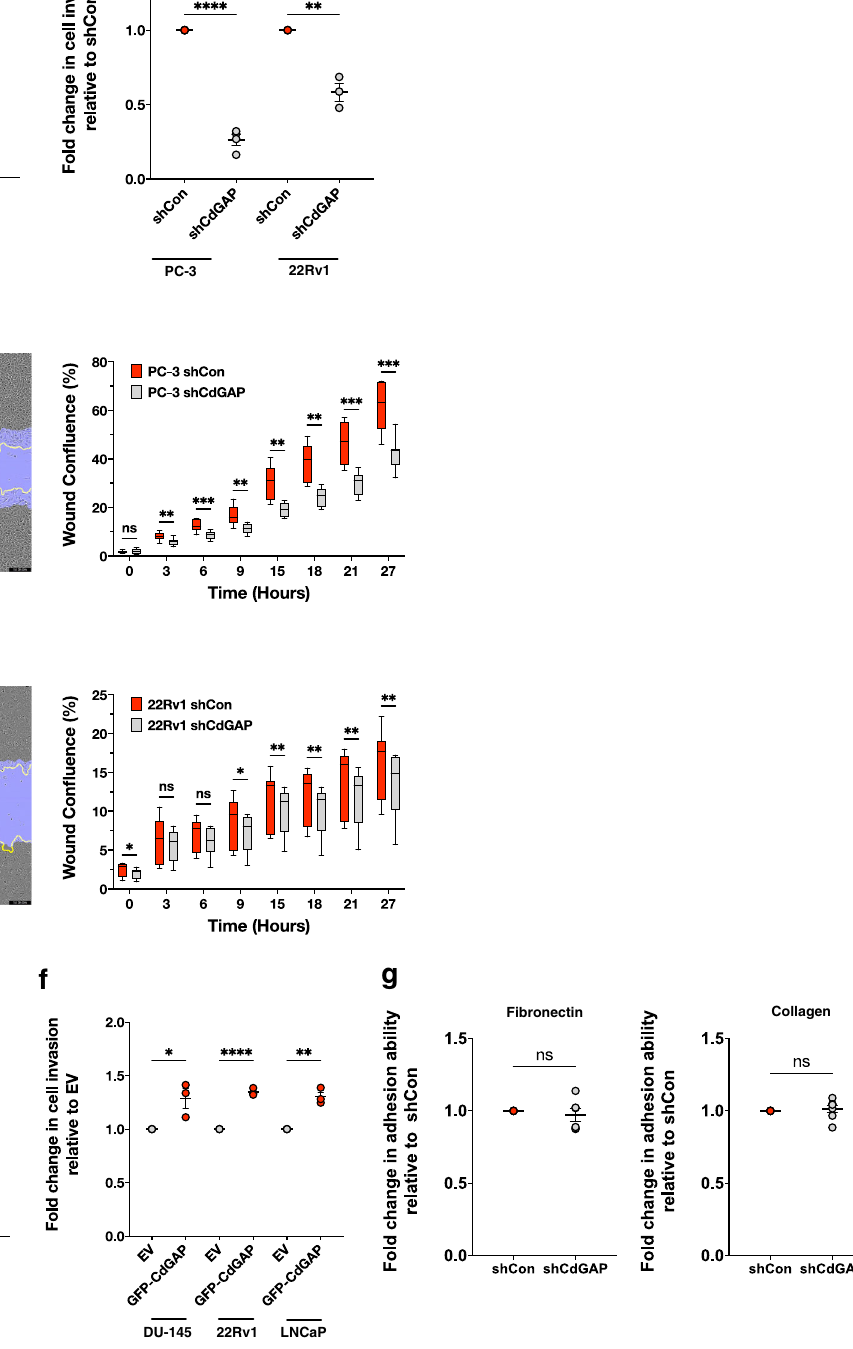
Fig. 3 CdGAP promotes cell migration and invasion in CRPC cells. a , b Quanti fi cation of transwell migration ( a ) and invasion ( b ) assays of CdGAP- depleted PC-3 and 22Rv1 (shCdGAP) cells with corresponding controls (shCon) ( n = 3). c , d Representative images from the wound healing assays of CdGAP-depleted PC-3 ( c ) and 22Rv1 ( d ) (shCdGAP) cells with corresponding controls (shCon). Scale bar, 400 μ m. Quanti fi cation of the wound con fl uence over a period of 27 h ( n = 3). e , f Quanti fi cation of transwell migration ( e ) and invasion ( f ) assays of DU-145, 22Rv1, and LNCaP cells transfected with either empty vector (EV) or GFP-CdGAP (22Rv1, LNcaP: n = 3; DU-145: n = 4). g Adhesion assays of CdGAP-depleted PC-3 (shCdGAP) and control cells (shCon) on fi bronectin and collagen type 1 ( n = 4). Two-sample unpaired Student ’ s t test for comparison between two groups. Error bars indicate SEM. **** p < 0.0001 *** p < 0.001; ** p < 0.01; * p < 0.05. n.s. not signi fi